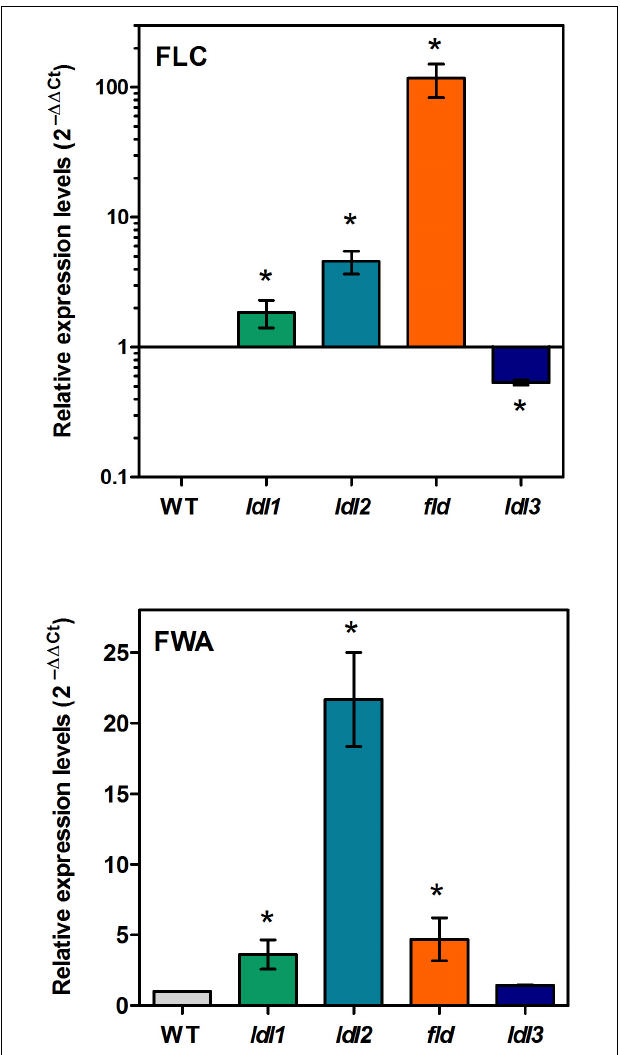
FIGURE 8 | Relative expression levels of FLC and FWA in Arabidopsis mutants for LDL / FLDs . Two-week-old seedlings of ldl1 , ldl2 , fld , and ldl3 mutants, and wild-type plants (WT) were analyzed for FLC and FWA expression levels by qRT-PCR. Data for FLC are shown in logarithmic scale. Numbers are mean values ± SE of three independent replicates. Asterisks indicate statistically significant differences from WT plants (one-way ANOVA test, p <